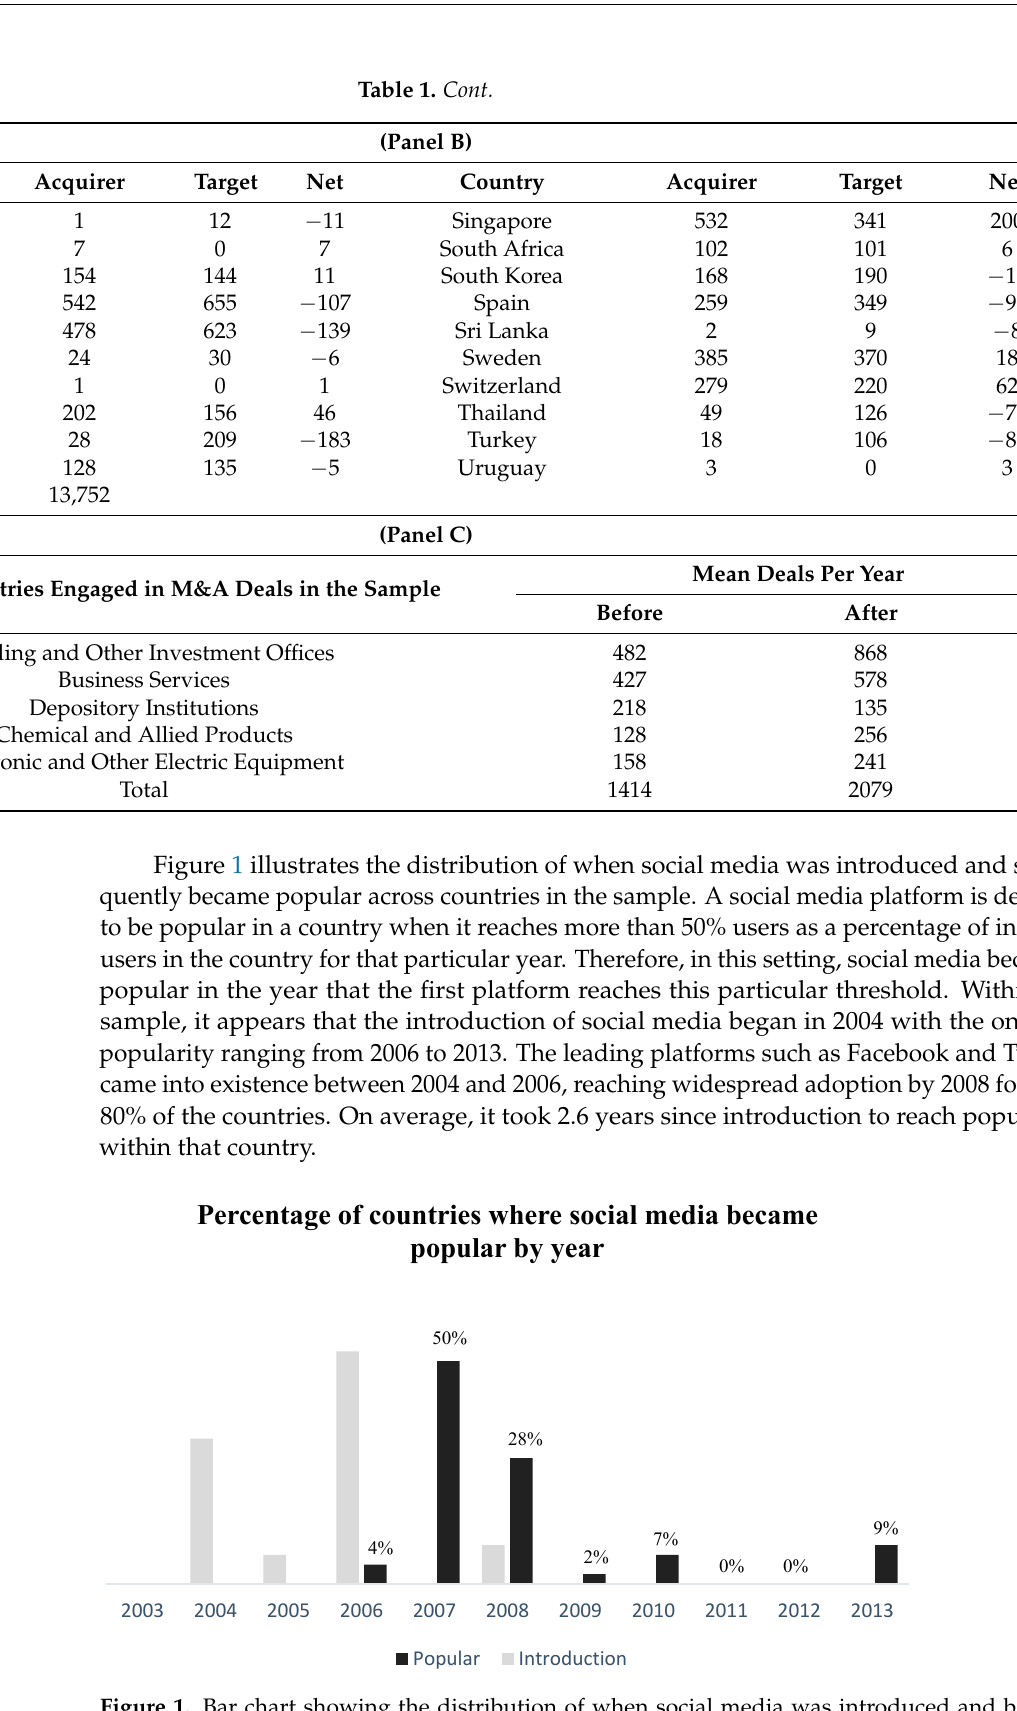
Figure 1. Bar chart showing the distribution of when social media was introduced and became popular across countries. The percentages displayed is calculated as the number of countries with observations in that year as a proportion of the total number of countries (46).